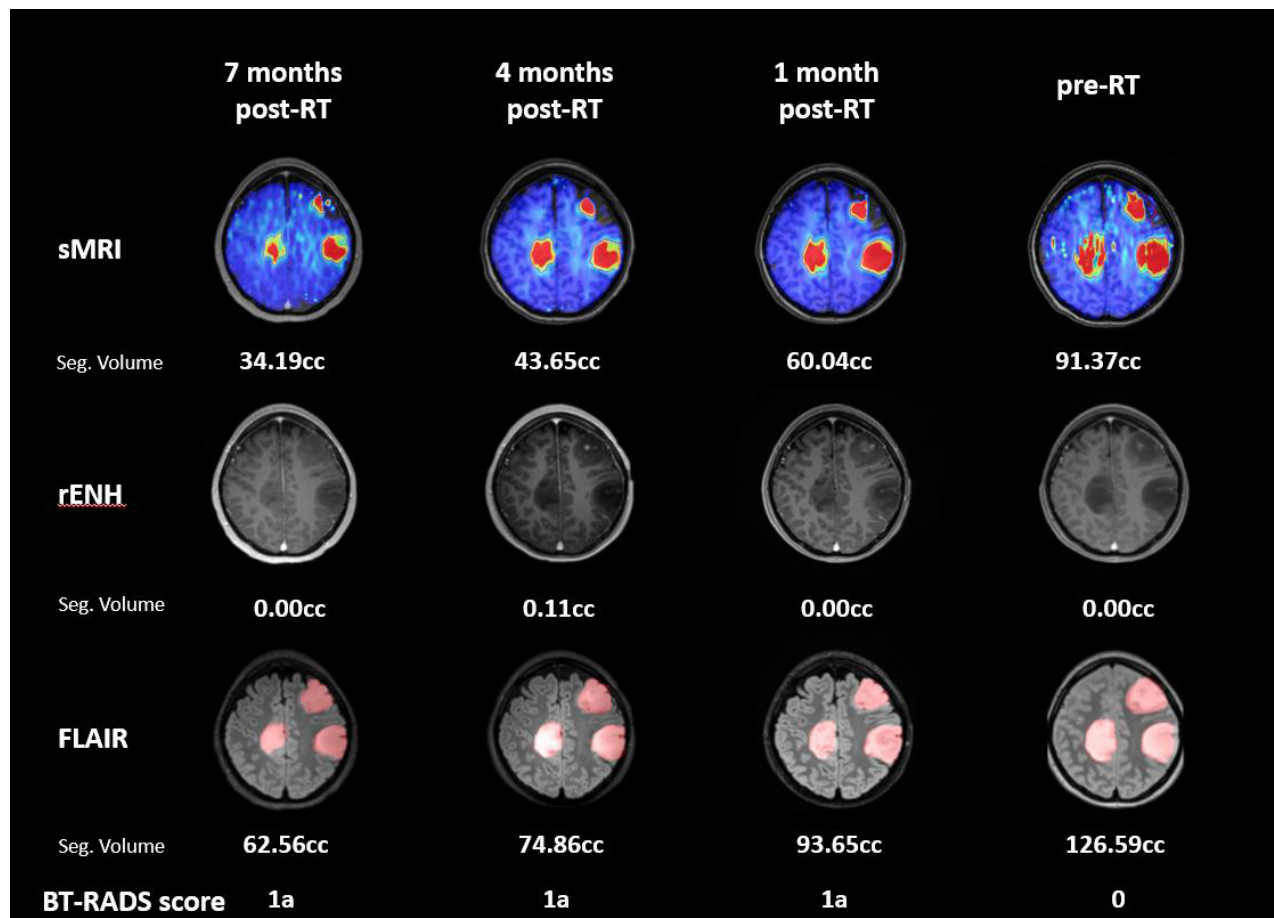
Figure 6. Subject 2 longitudinal follow-up imaging shown in BrICS-LIT. Four follow-up images and their corresponding sMRI, T1w-CE, and T2 FLAIR are shown chronologically from right to left, with the pre-RT treatment planning image first. Lesion volumes have been segmented, and each follow-up is scored by a neuroradiologist. Little to no contrast enhancing tumor was seen in follow-ups. The imaging shows a positive response to treatment with decreasing volumes on sMRI from pre-RT to 7 months post-RT; the FLAIR volumes also decreased during this time period. Each follow-up is scored as BT-RADS 1a corresponding to disease improvement.